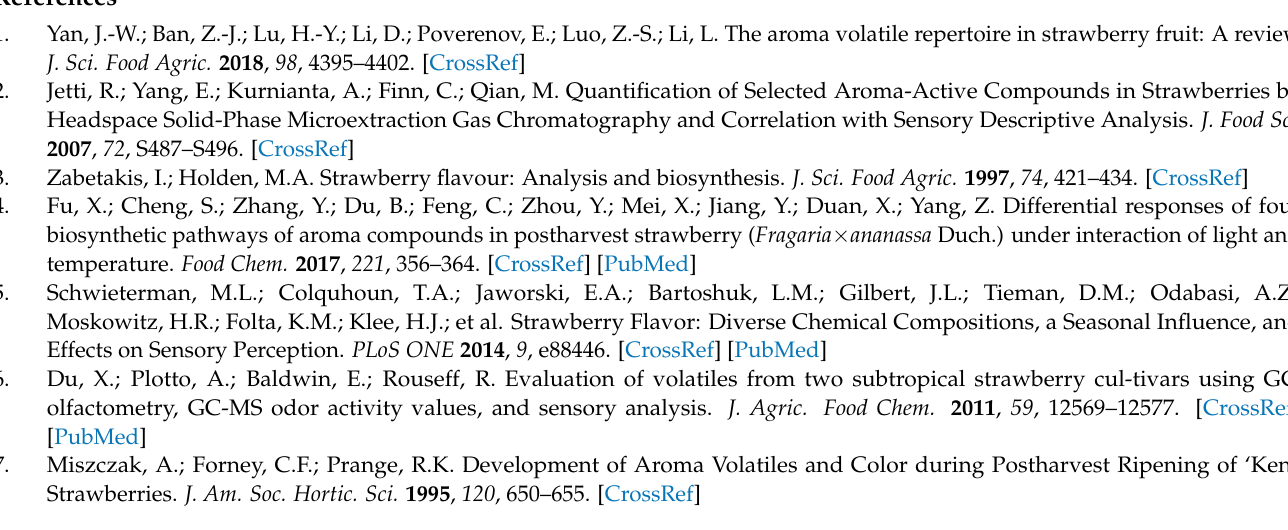
Table S2. Primers used in RT-qPCR. Table S3. Volatile compounds detected in strawberry fruit using GC-MS analysis. Figure S1. Volatiles of ‘Amaou’ and ‘Yuexin’ under soil cultivation